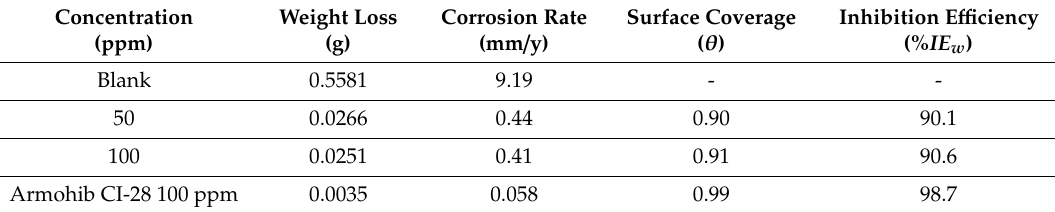
Table 3. Inhibition e ffi ciency, corrosion rate, and surface coverage of WPU-7 at di ff erent concentrations in 2M